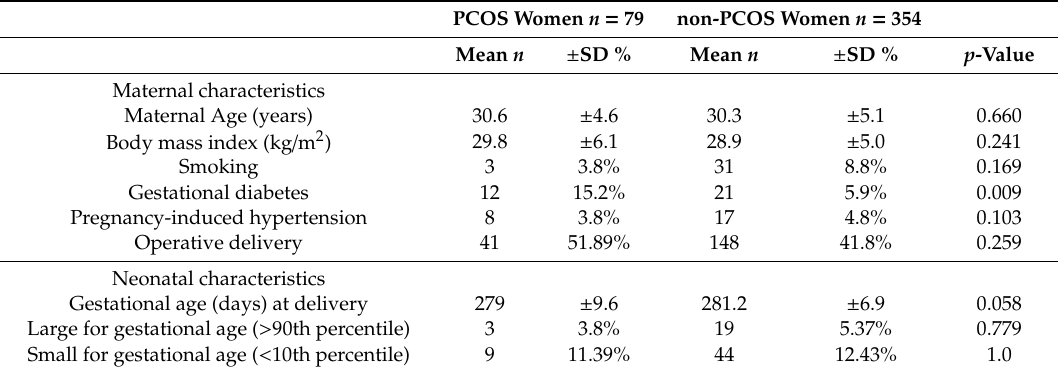
Table 1. Comparison of demographics.